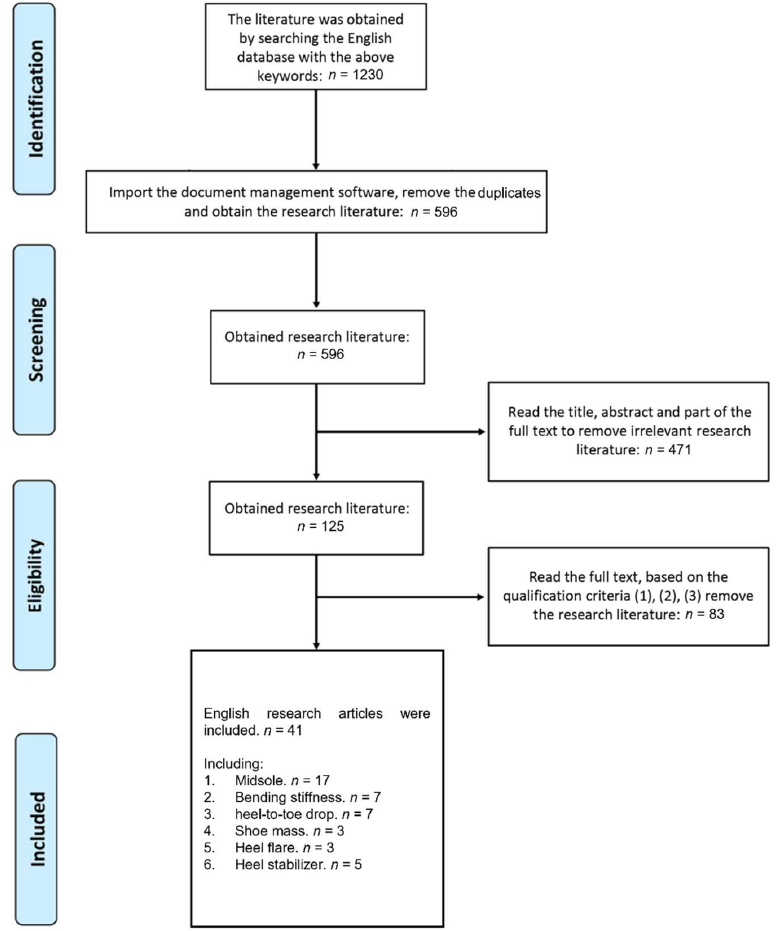
Figure 1. PRISMA Flow Chart for Systematic review.